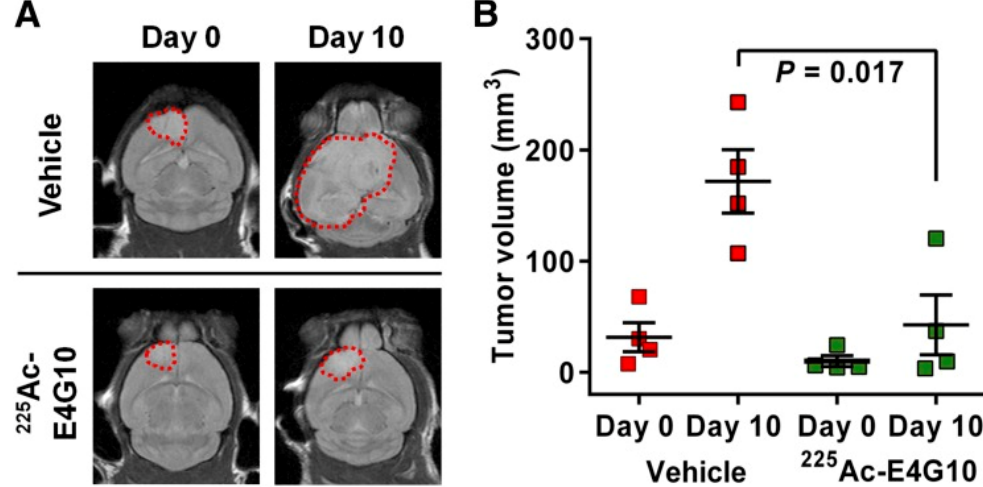
Figure 4. ( A ) Tumor sizes of control and [ 225 Ac]Ac-E4G10 treated glioblastoma-bearing mice before and after 10 days, imaged by MRI. ( B ) Mean tumor volumes for control and [ 225 Ac]Ac-E4G10- imaged by MRI. ( B ) Mean tumor volumes for control and [ 225 Ac]Ac-E4G10-treated mice. Reproduced from [81], JNM, treated mice [81].